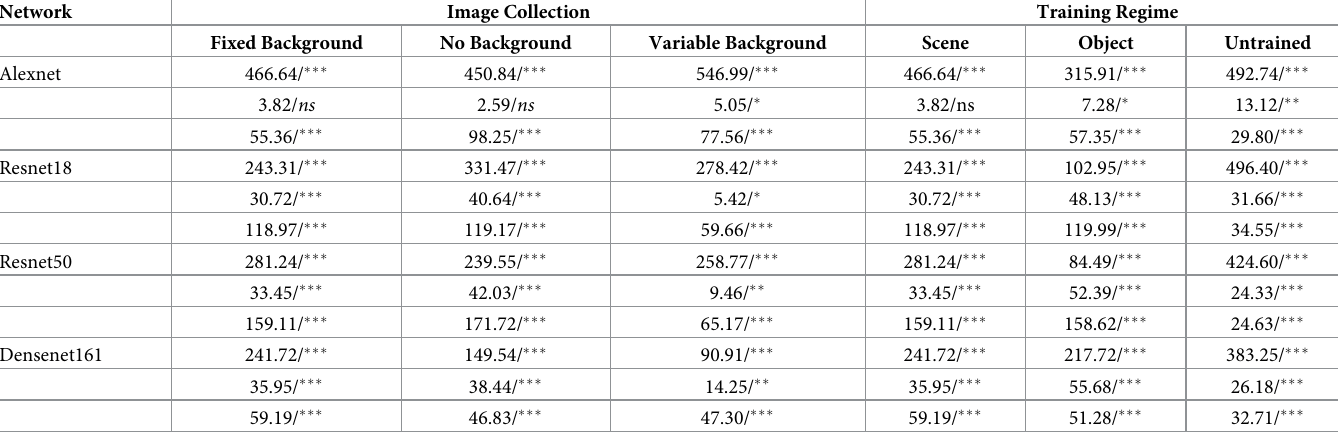
Table 4. Statistical results of repeated measure ANOVA tests comparing the two types of Euclidean distance measures (Different Object/Same Configuration, Same Object/Different Configuration).